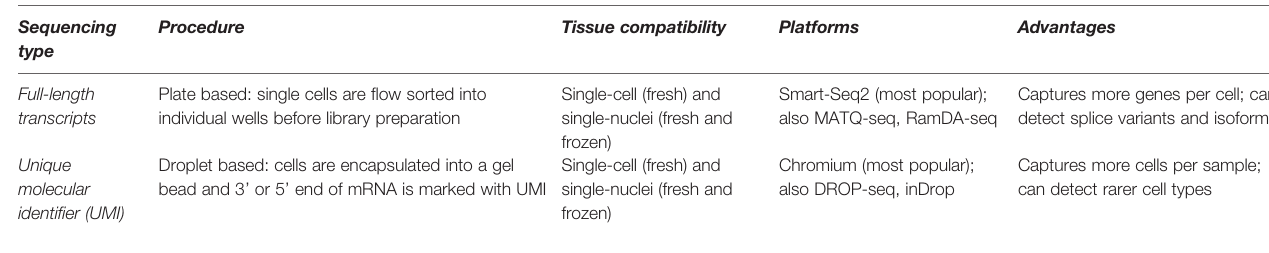
TABLE 1 | Comparison of single-cell RNA-seq